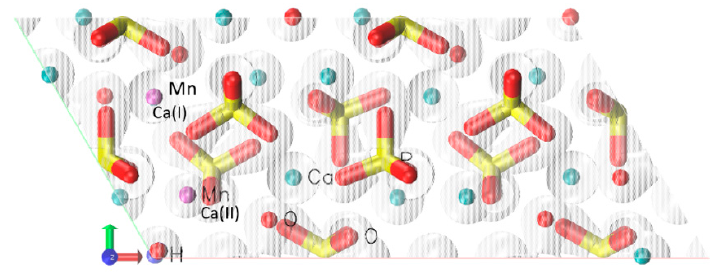
Figure 1. Example of calculating electron density using the Quantum Espresso software for hydrox-